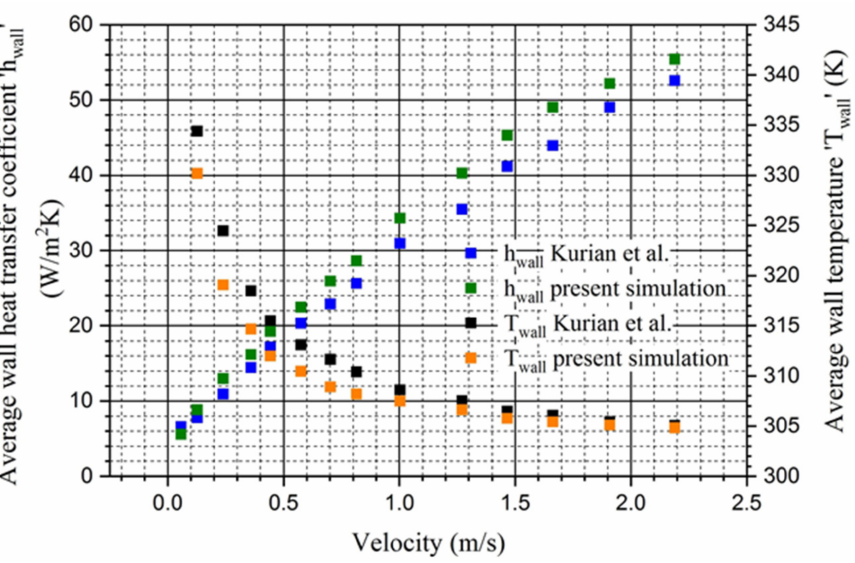
Figure 10. Comparison of wall heat transfer coefficient obtained from present numerical work to that of experimental work of